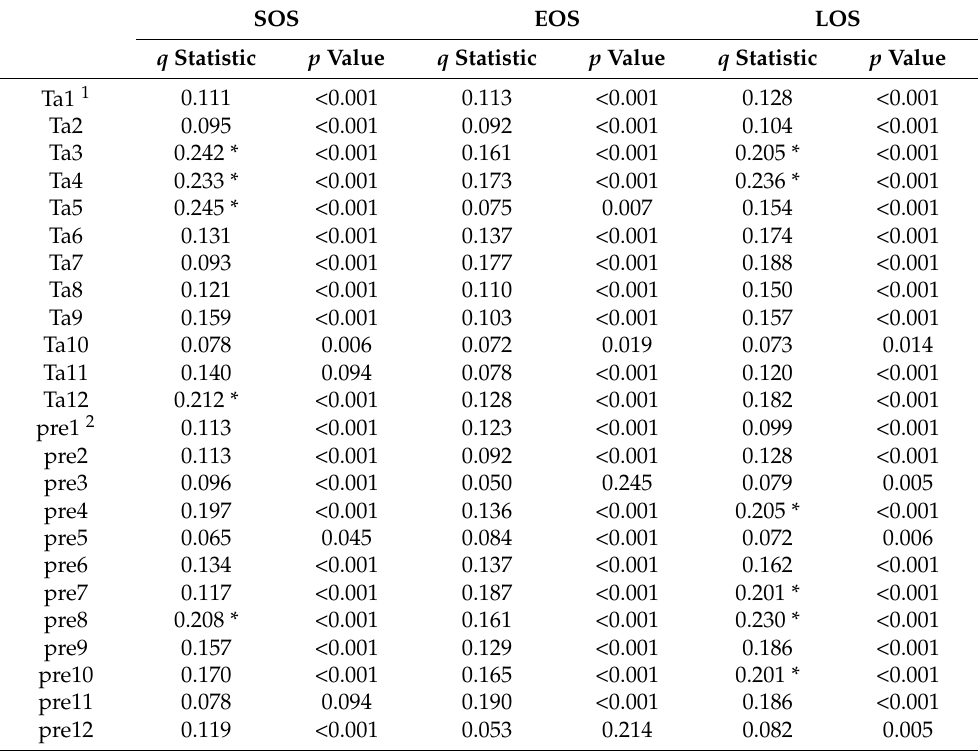
Table 1. Q statistics and the significance of phenological parameters when interpreting their trends by monthly average temperature and precipitation with